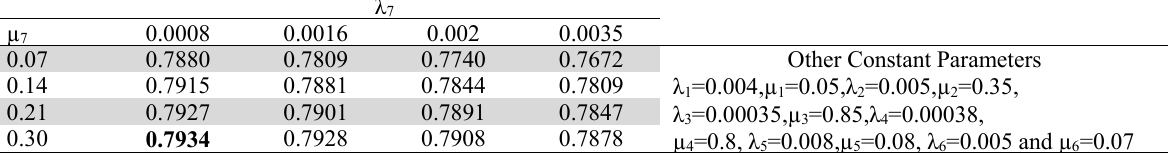
Effect of failure and repair rates of crowning machine on system